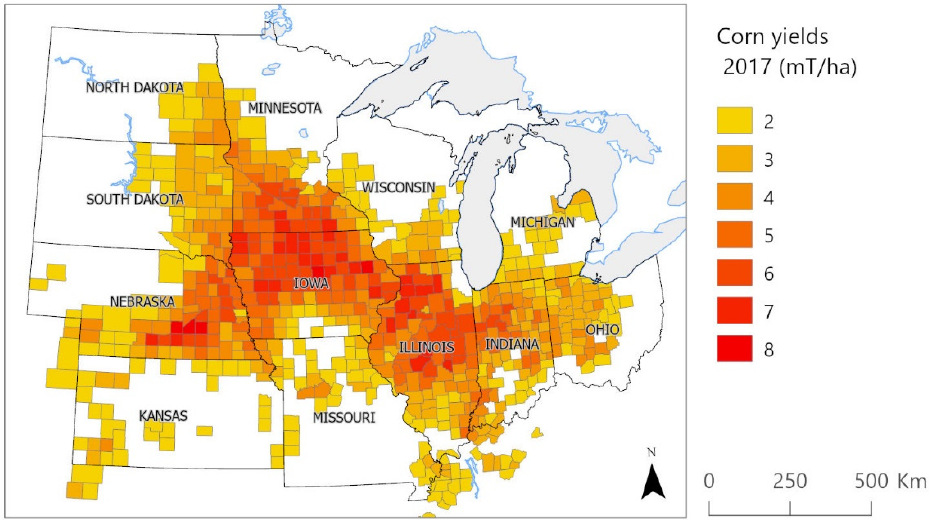
Figure 1. Leading Corn Belt states, with yields from 2017 census of agriculture.